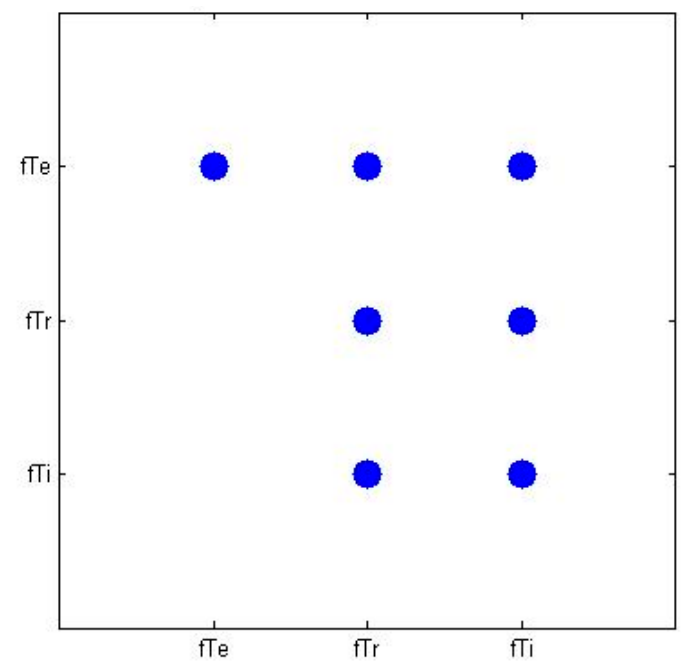
Figure 3. Fault isolability matrix for scenario 1, where the relationship between the faults can be seen. The faults f Tr and f Ti does not occur if f Te is a fault. However, if the faults f Tr or f Ti occurs, all faults within scenario 1 will be present as they are isolated from each